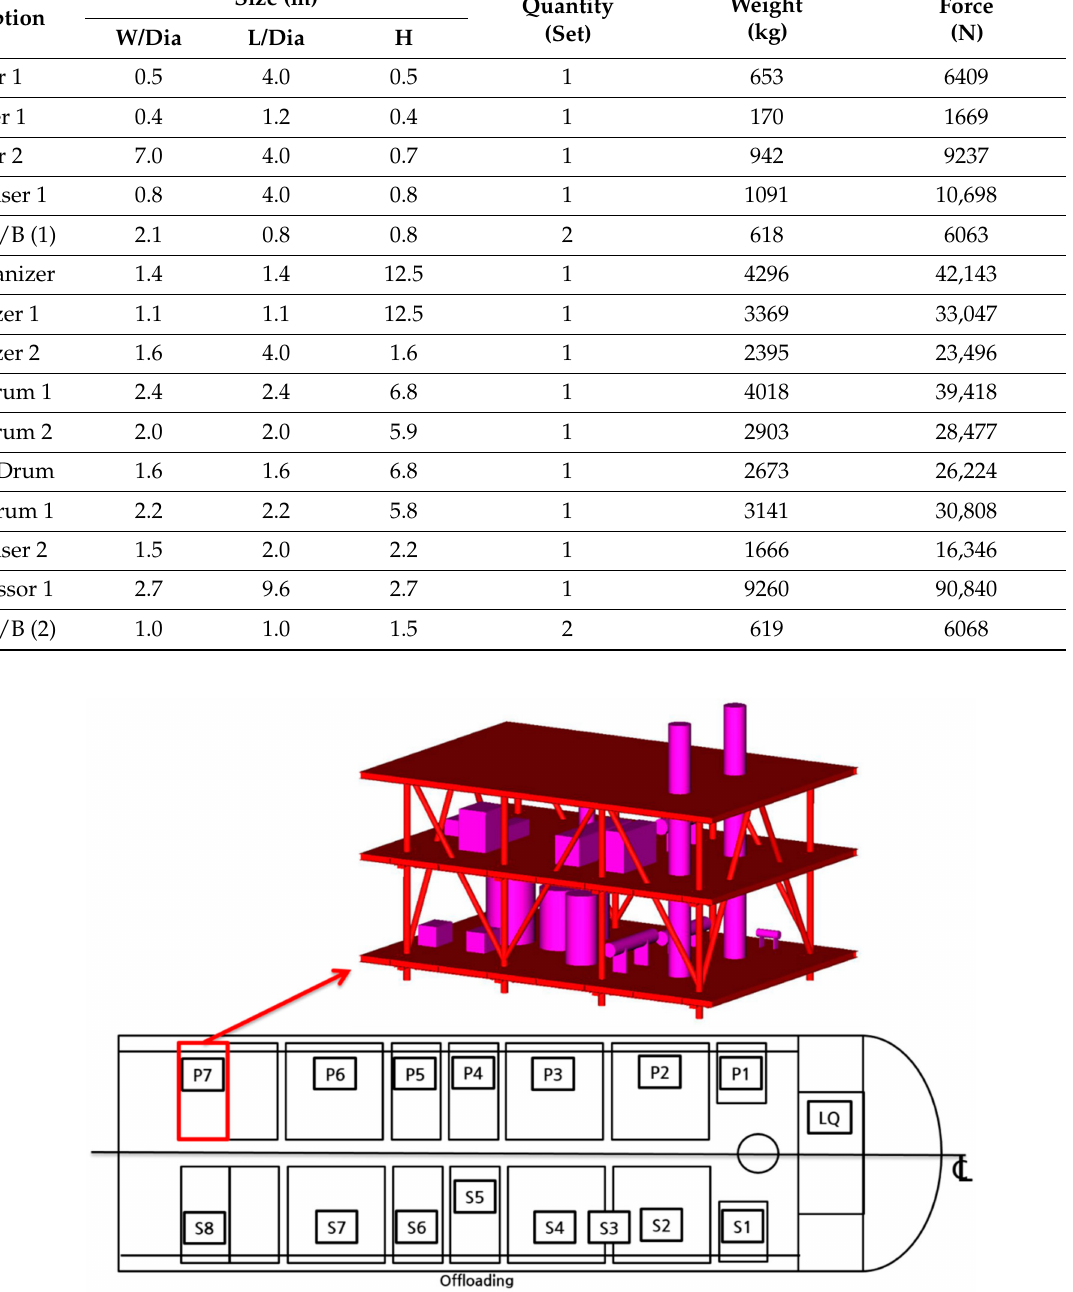
Figure 3. Overall layout of the fractionation